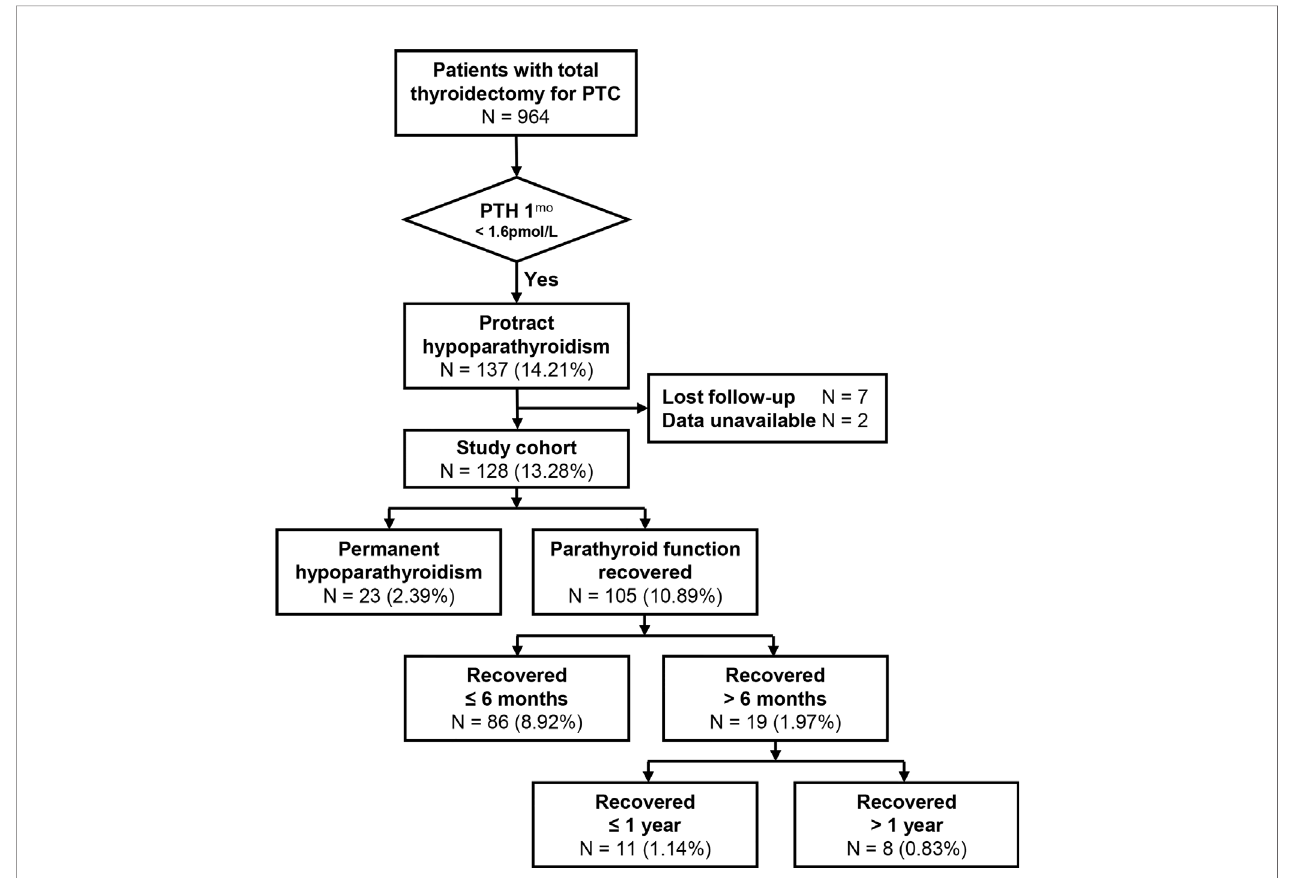
FIGURE 1 | Patient fl ow diagram. Highlighted area encloses the study patients. Percentages are over the immediately preceding group. PTH, parathormone; 1 mo , 1 month